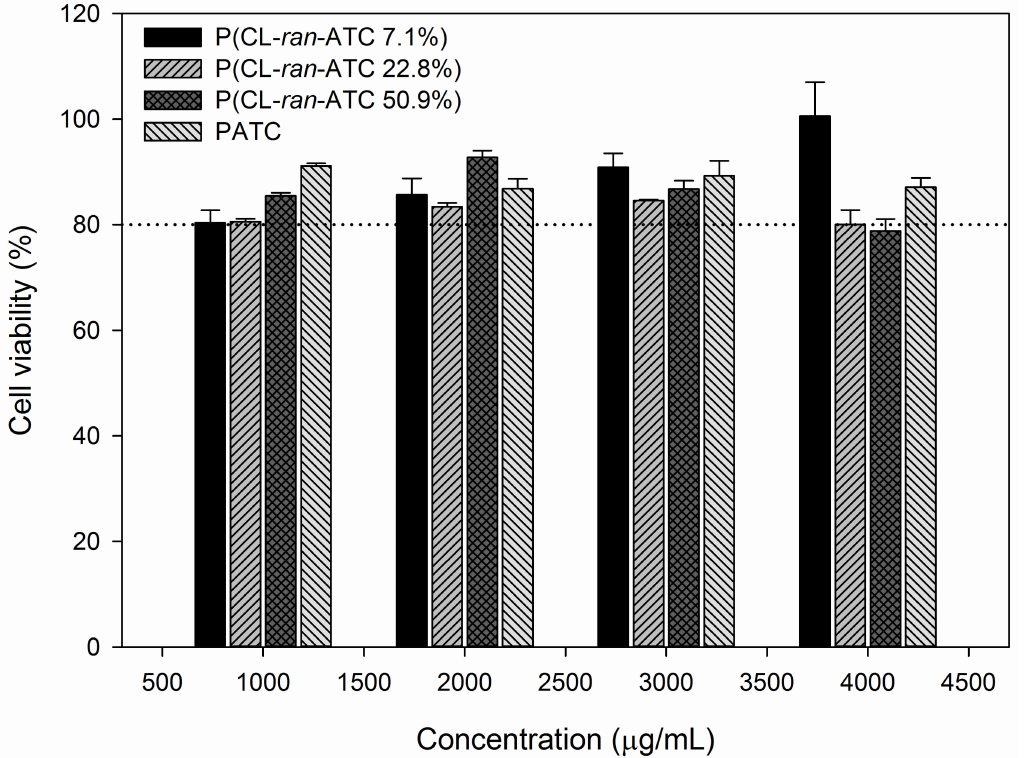
Figure 5. Cytotoxicity of P(CL- ran -ATC)s against fibroblast L929